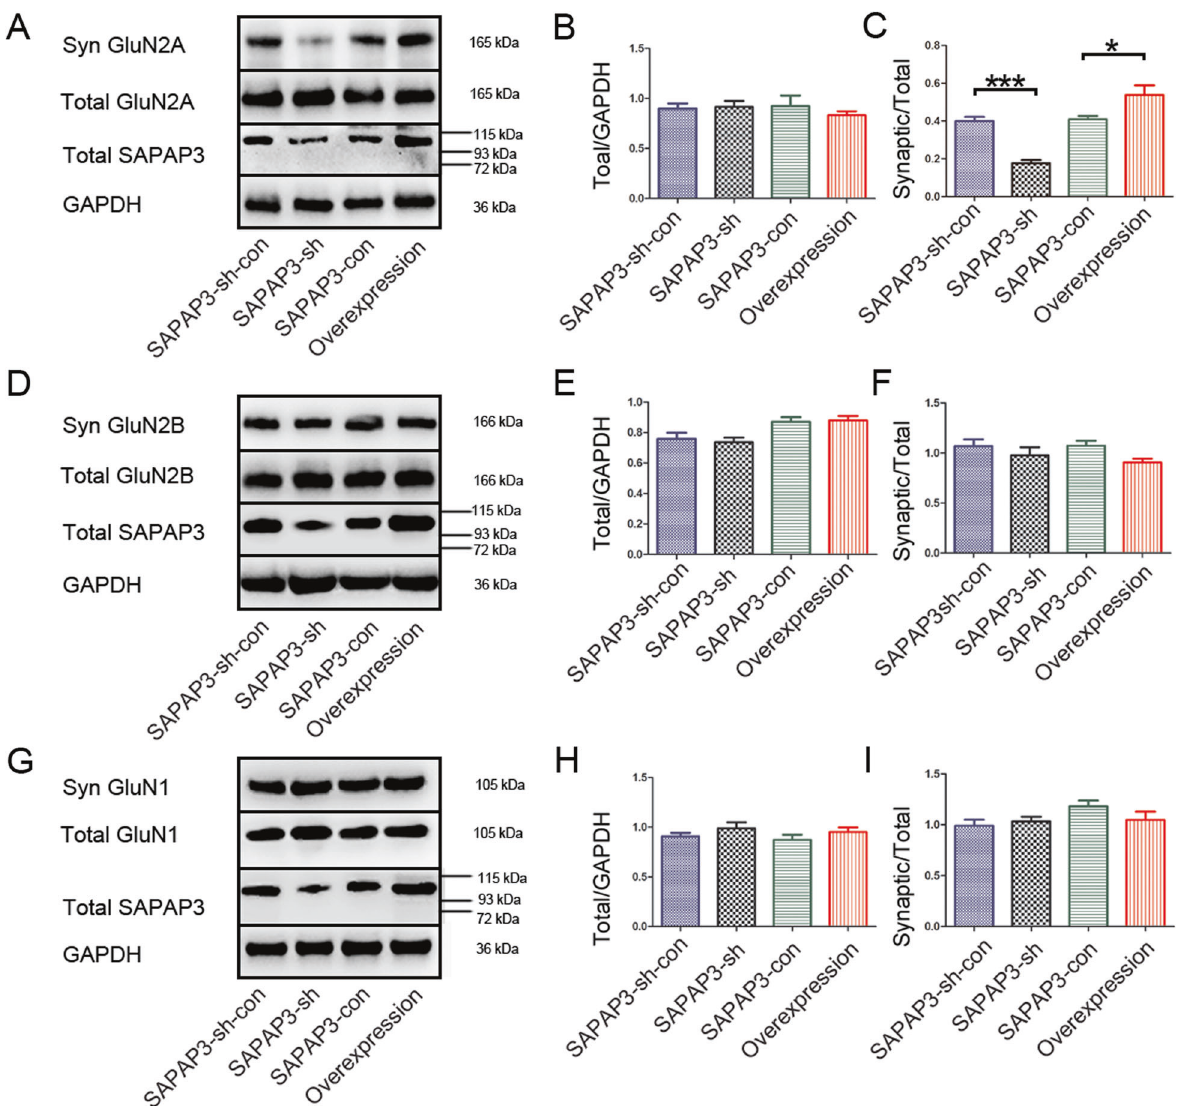
Fig. 6 Expression of GluN1, GluN2A and GluN2B in total homogenates and the PSD after the behavioral evaluation. A – C Representative western blot of the GluN2A levels in total tissue homogenates and subcellular fractions ( A ). No signi fi cant differences in the total GluN2A levels were found among the groups ( B ). Compared with the control group, the SAPAP3-sh vector signi fi cantly decreased the synaptic/total GluN2A ratio. SAPAP3 overexpression signi fi cantly increased the synaptic/total GluN2A ratio ( C ). Representative western blots of the GluN2B ( D ) and GluN1 levels ( G ) in total tissue homogenates and subcellular fractions. No signi fi cant differences in the total GluN2B and GluN1 levels were found among the groups ( E and H ). The synaptic/total GluN2B and GluN1 ratios were not signi fi cantly different compared with those